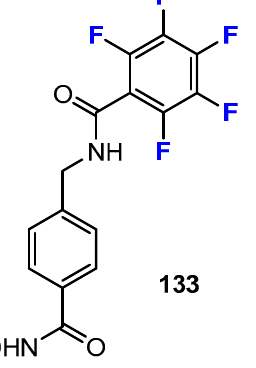
Figure 6. Chemical structure of fluorinated hydroxamic acid (PTG-0861) by Gawel, Shouksmith, Raouf, Nawar et al. [71].